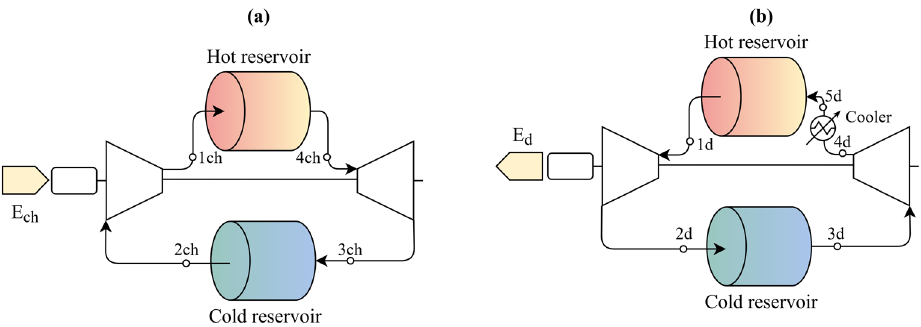
Figure 2. Brayton PTES system with solid-based thermal exergy storage (SBPTES): ( a ) charge system; ( b ) discharge system.